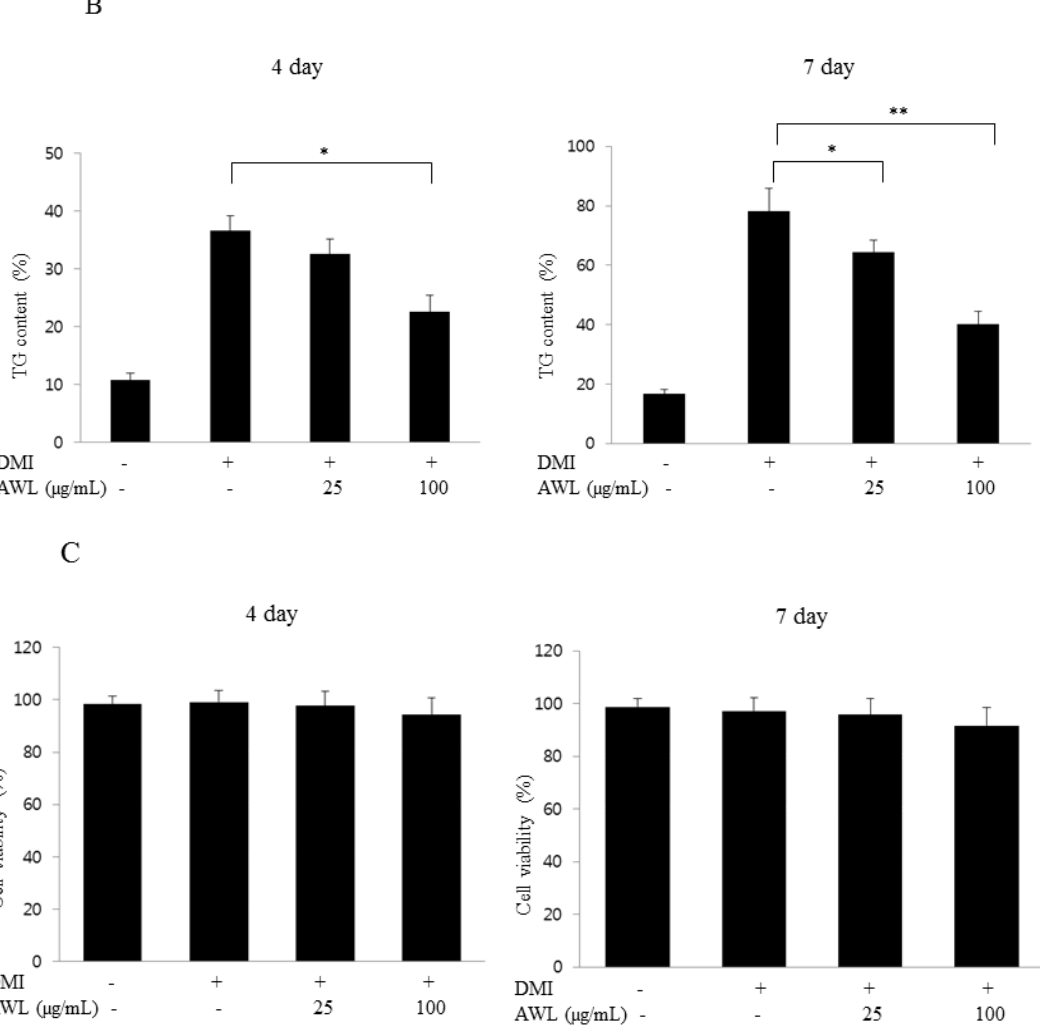
Figure 1. Effects of AWL on lipid accumulation and adipocyte differentiation in 3T3-L1 cells. ( A ). 3T3-L1 cells were induced to differentiate with DMI and AWL in increasing concentrations (0, 25, and 100 µ g/mL) for seven days. The cellular lipid content was assessed by Oil Red O staining. DMI: 0.5 mM 3-IBMX, 100 µ M indomethacin, 0.25 µ M dexamethasone and 167 nM insulin. AWL: annual wormwood leaves extracts. ( B ) AWL inhibited TG accumulation in 3T3-L1 adipocytes. Three independent experiments were used to represent the error bars. * p < 0.05, ** p < 0.01. ( C ) cytotoxicity of AWL in 3T3-L1 cells. Viability of the AWL-treated cells was determined by the MTT assay. The values are presented as the means ± SD. The data shown are representative of at least three independent experiments.